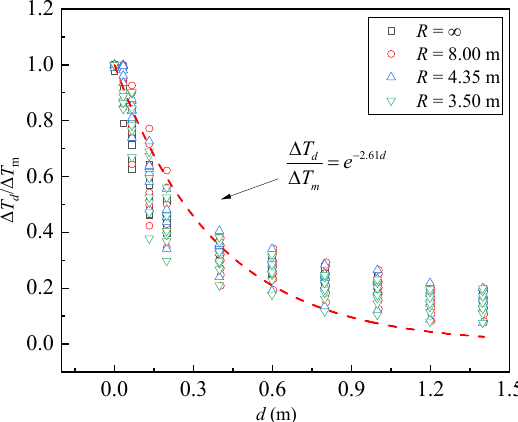
Figure 8. Longitudinal attenuation of temperature below the tunnel ceiling with different turning   radiuses: ( a ) Q = 0.76 kW; ( b ) Q = 1.01 kW; ( c ) Q   kW; ( f ) Q = 3.05 kW; ( g ) Q = 4.06 kW.